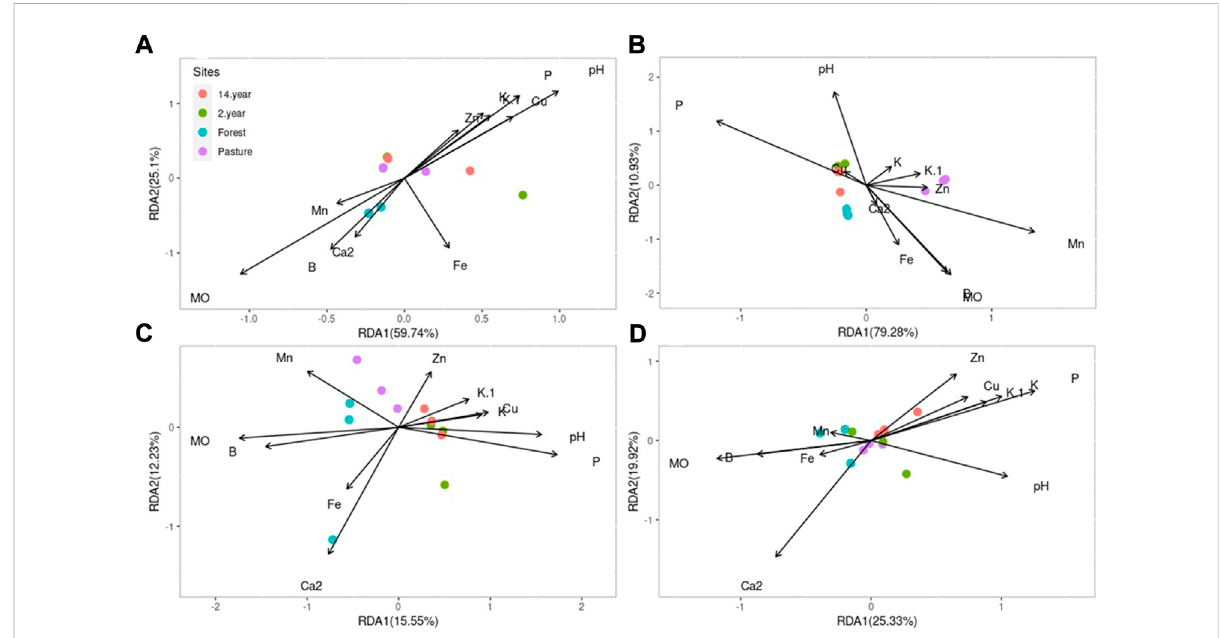
FIGURE 4 RDA analysis of chemical variables and Shannon ’ s alpha diversity index at all sites each site of the organisms (A) bacteria, (B) archaea, (C) virus and (D)